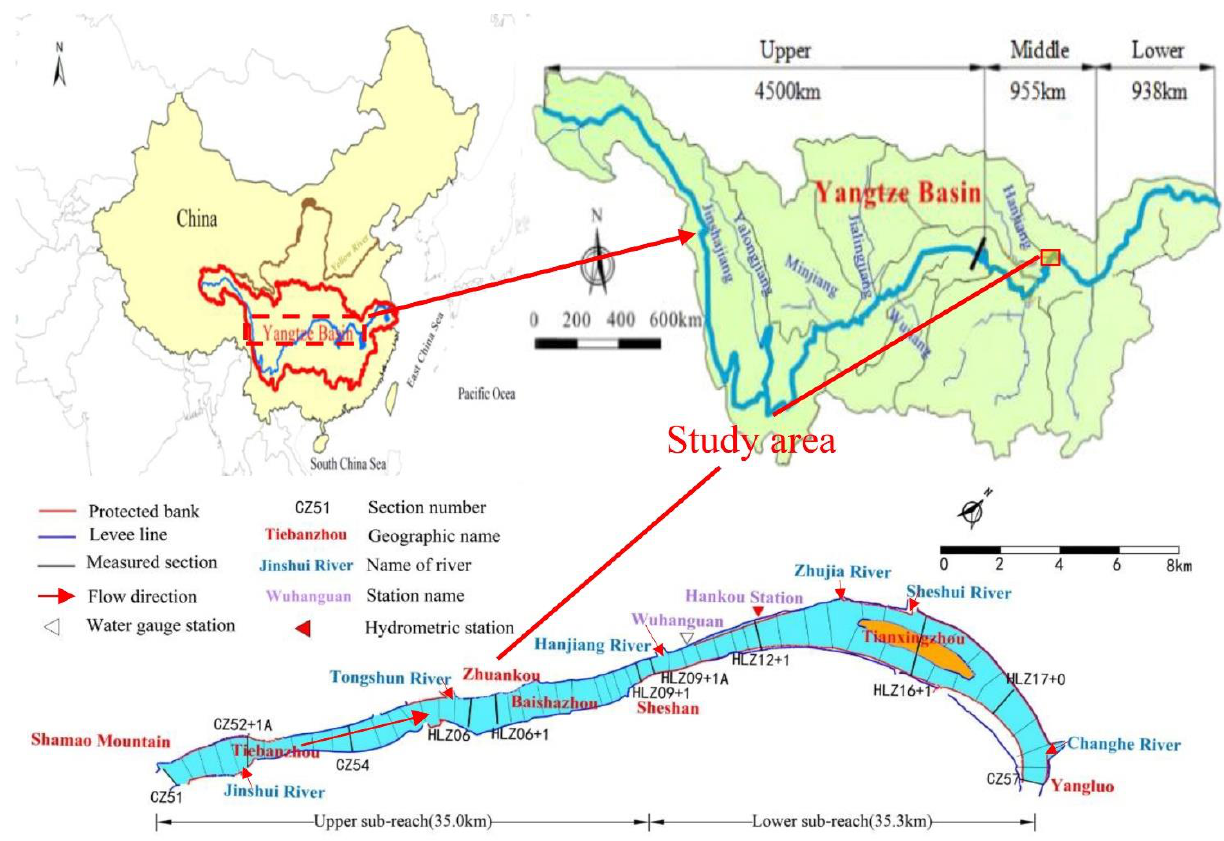
Figure 1. River regime map of the Wuhan reach of the Yangtze River. Table 2. Sources of measurements.